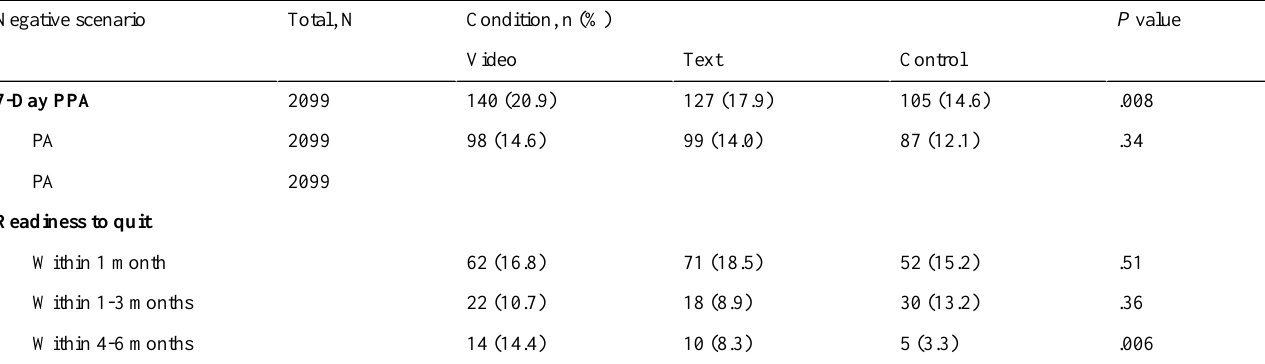
Table 2. Six-month abstinence rates, including 7-day point prevalence abstinence (PPA) and prolonged abstinence (PA), for the video-based computer tailoring (video), text-based computer tailoring (text), and control conditions for sample 1 (negative scenario).